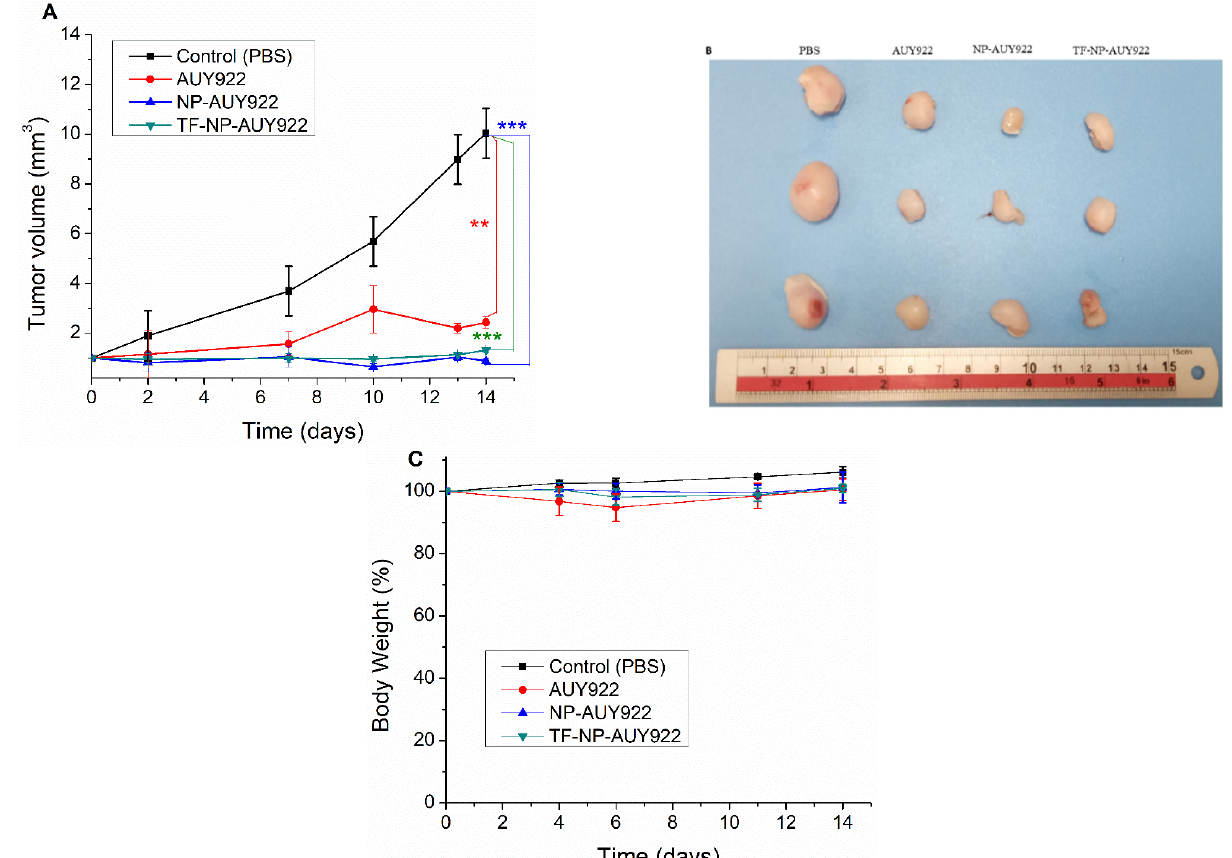
Figure 9. In vivo therapeutic efficacy of PBS (as a control), free AUY922, NP-AUY922, and TF-NP-AUY922 using U87 brain cancer-bearing NOD-SCID mice. The drugs were given on days 0, 3, 7, 10, and 13 (dosage: 20 mg/kg of mice for nanoformulated AUY922 and 40 mg/kg of mice for free AUY922). ( A ) Relative tumor volume, ( B ) selected images of the tumors collected on day 14, and ( C ) relative bodyweight of NOD-SCID mice. Data are presented as mean ± SD ( n = 5). (* p < 0.05, ** p < 0.01, *** p < 0.001). A one-tailed t-test was used for the p-value calculation for each control vs. treatment group.